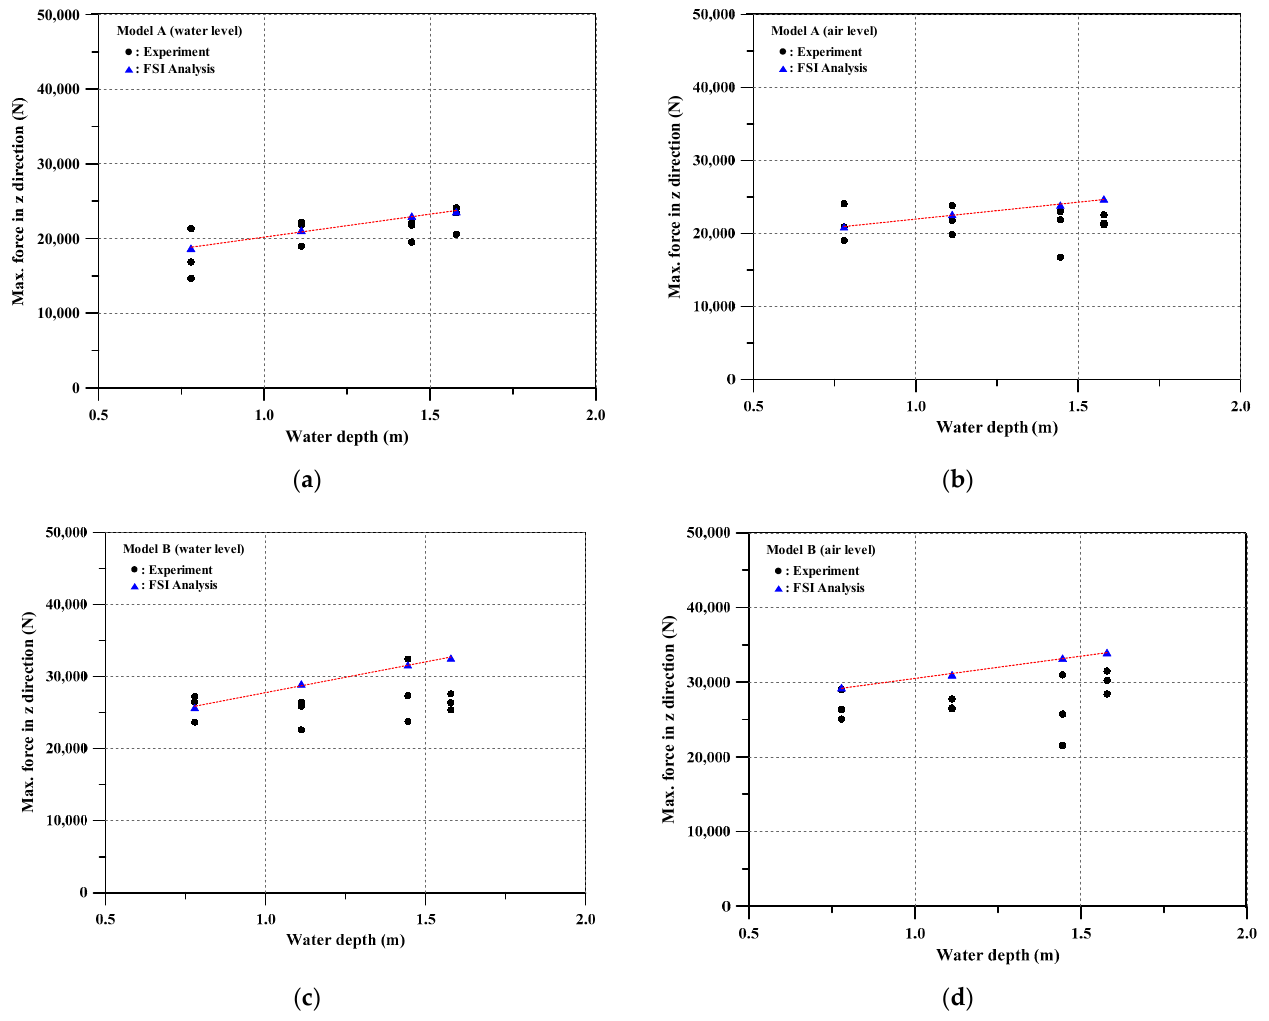
Figure 15. Comparison between experimental and numerical impact force : ( a ) Model A—water level; ( b ) Model A—air level; ( c ) Model B—water level; ( d ) Model B—air level